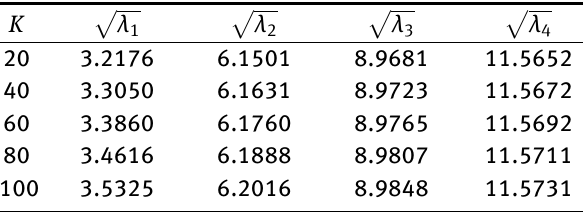
(︁ √ )︁ for CF nanobeam for different λ